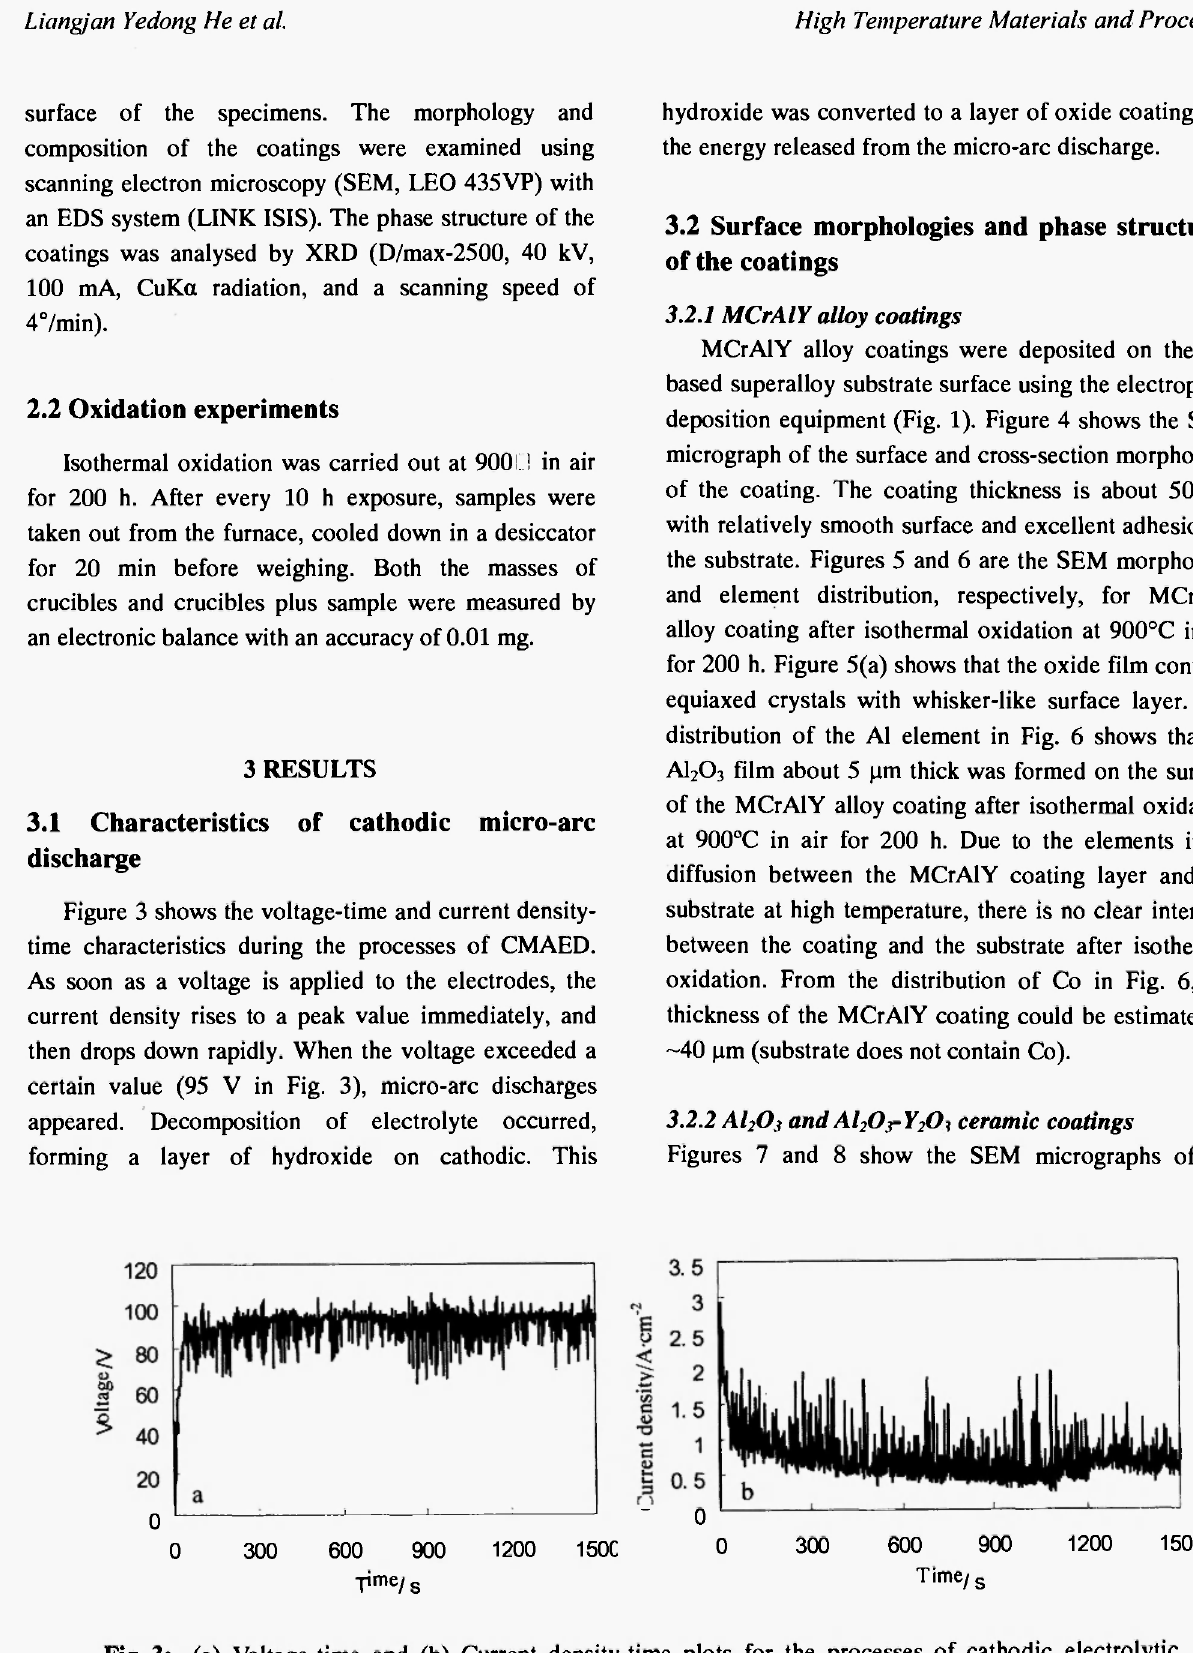
Fig. 3: (a) Voltage-time and (b) Current density-time plots for the processes of cathodic electrolytic